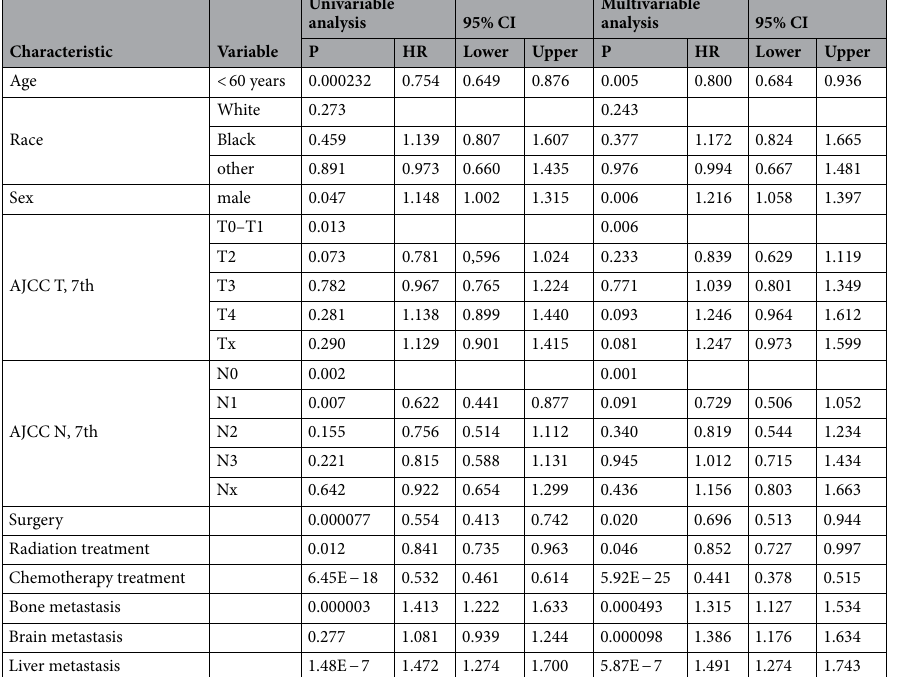
Table 2. Univariate multivariate analysis.